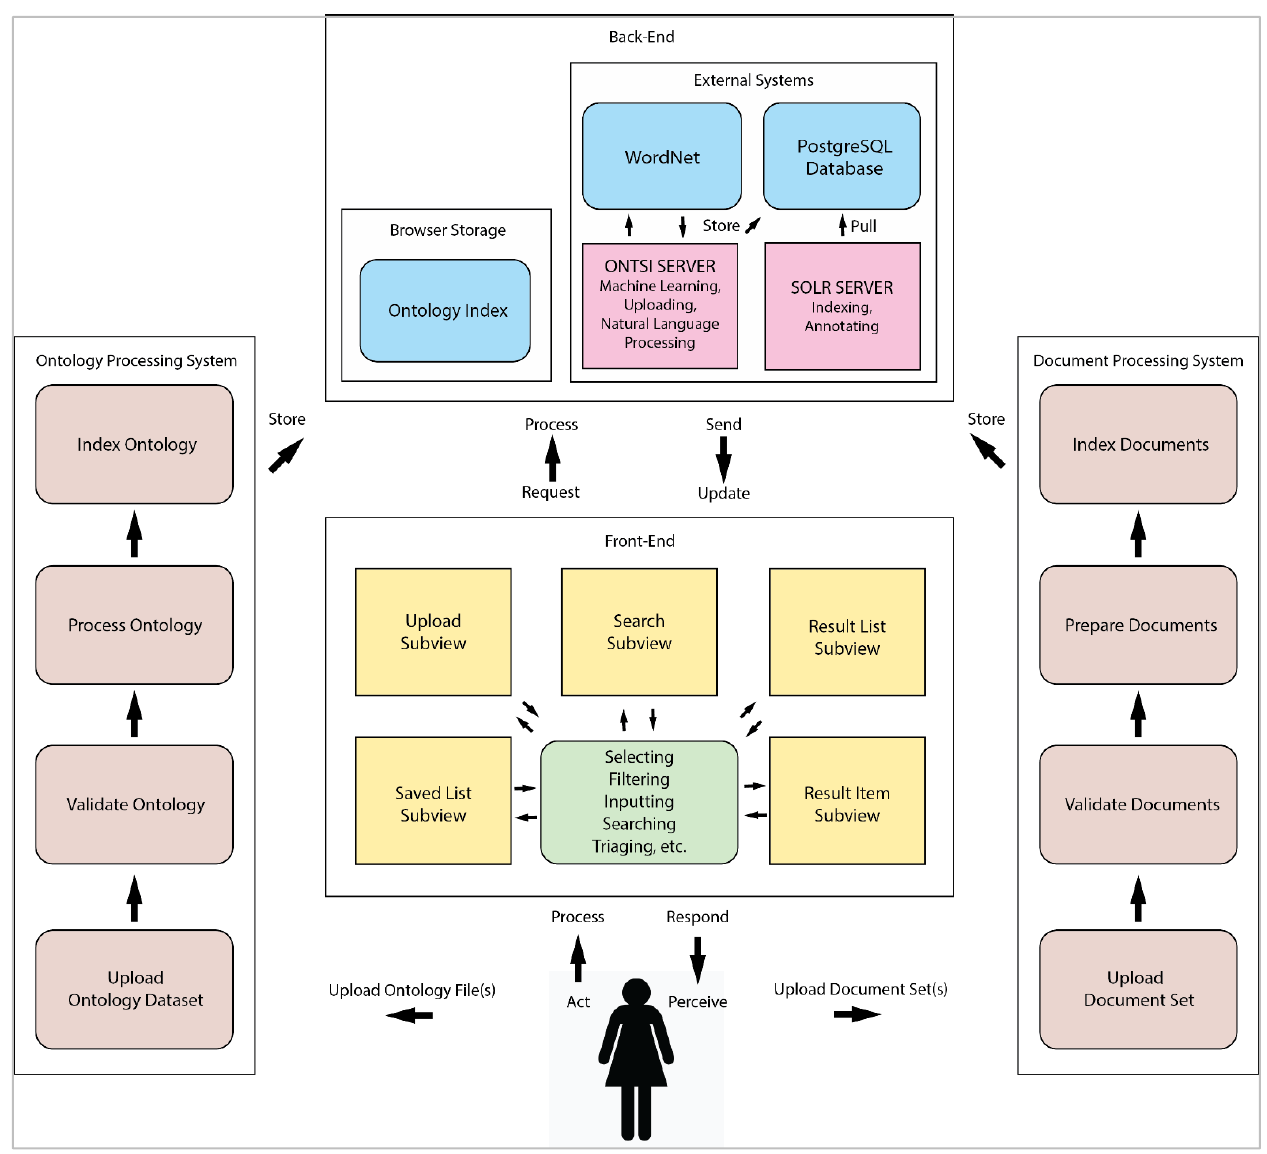
Figure 4. Depiction of the functional workflow of ONTSI. Labelled arrows reflect the steps of the interaction loop. Brown boxes represent the processes performed within the back-end computation systems. Blue boxes represent the object types that persist within the browser and external index database storage. Pink boxes represent the back-end computational systems of ONTSI. Yellow boxes represent the various subviews within the front end of ONTSI. The green box represents the types of interactions that can be conducted with the system.